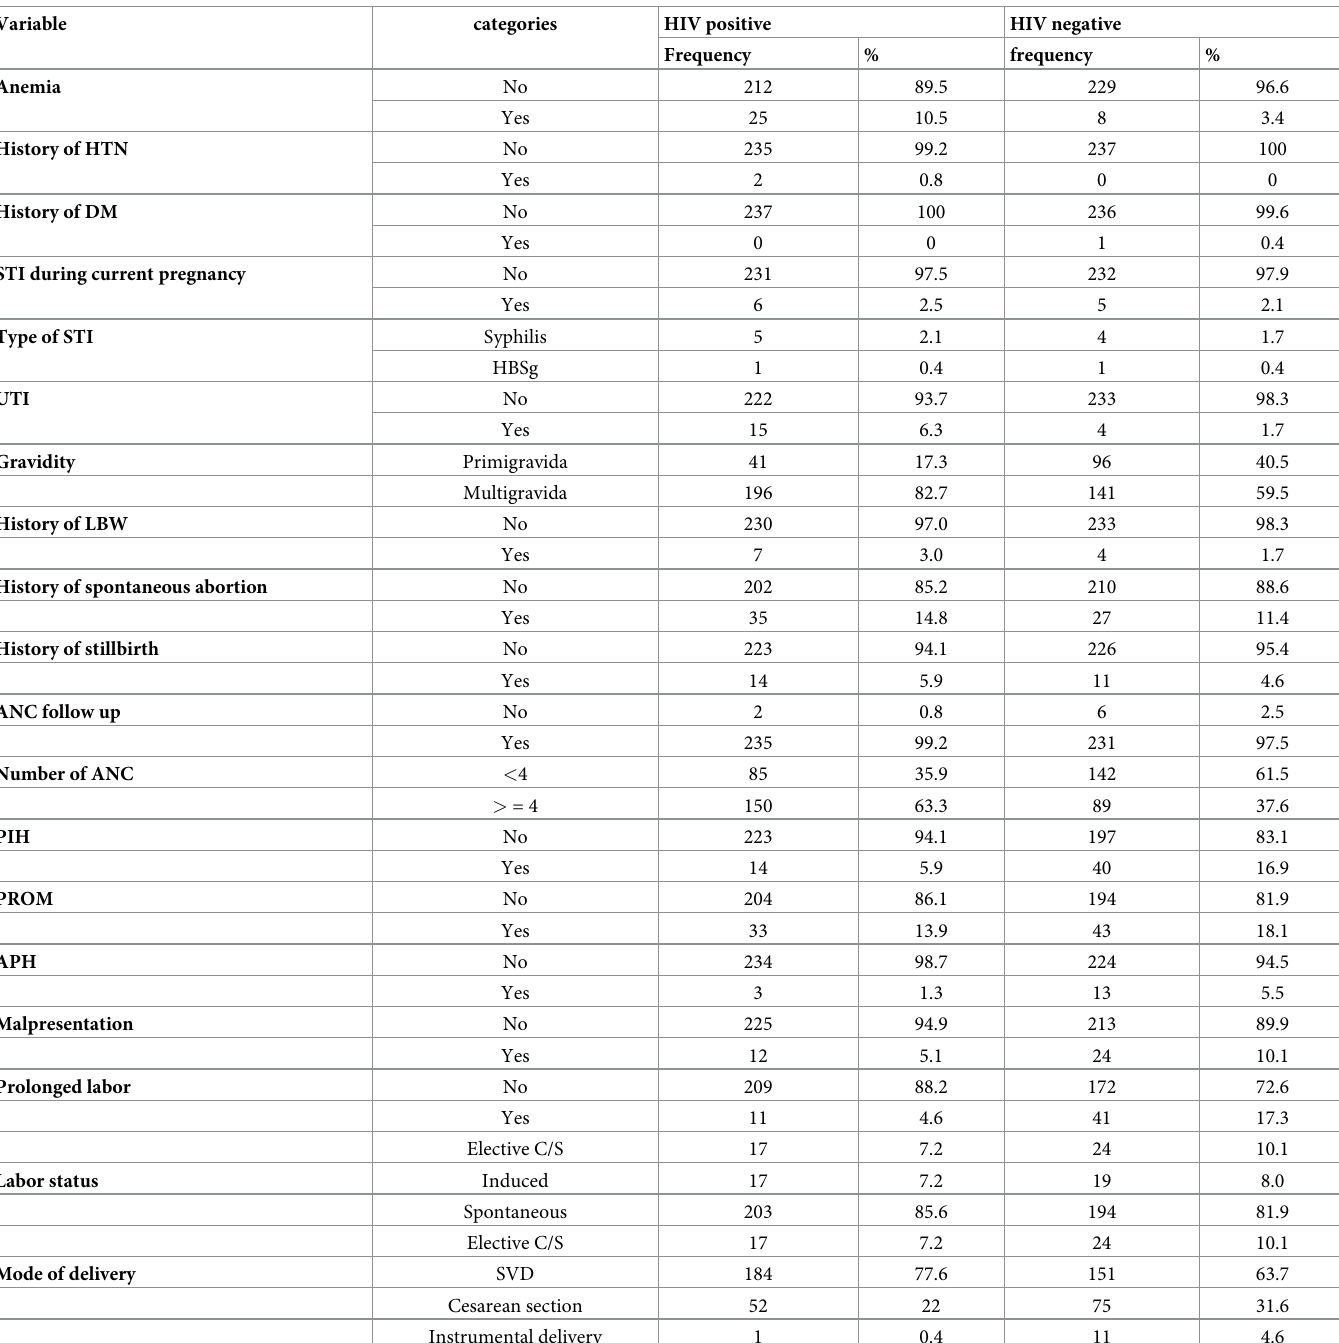
Table 2. Medical, obstetric related characteristics, Pregnancy and labor-related complications of the mothers delivered in Northwest Amhara regional state referral hospitals (N = 474).